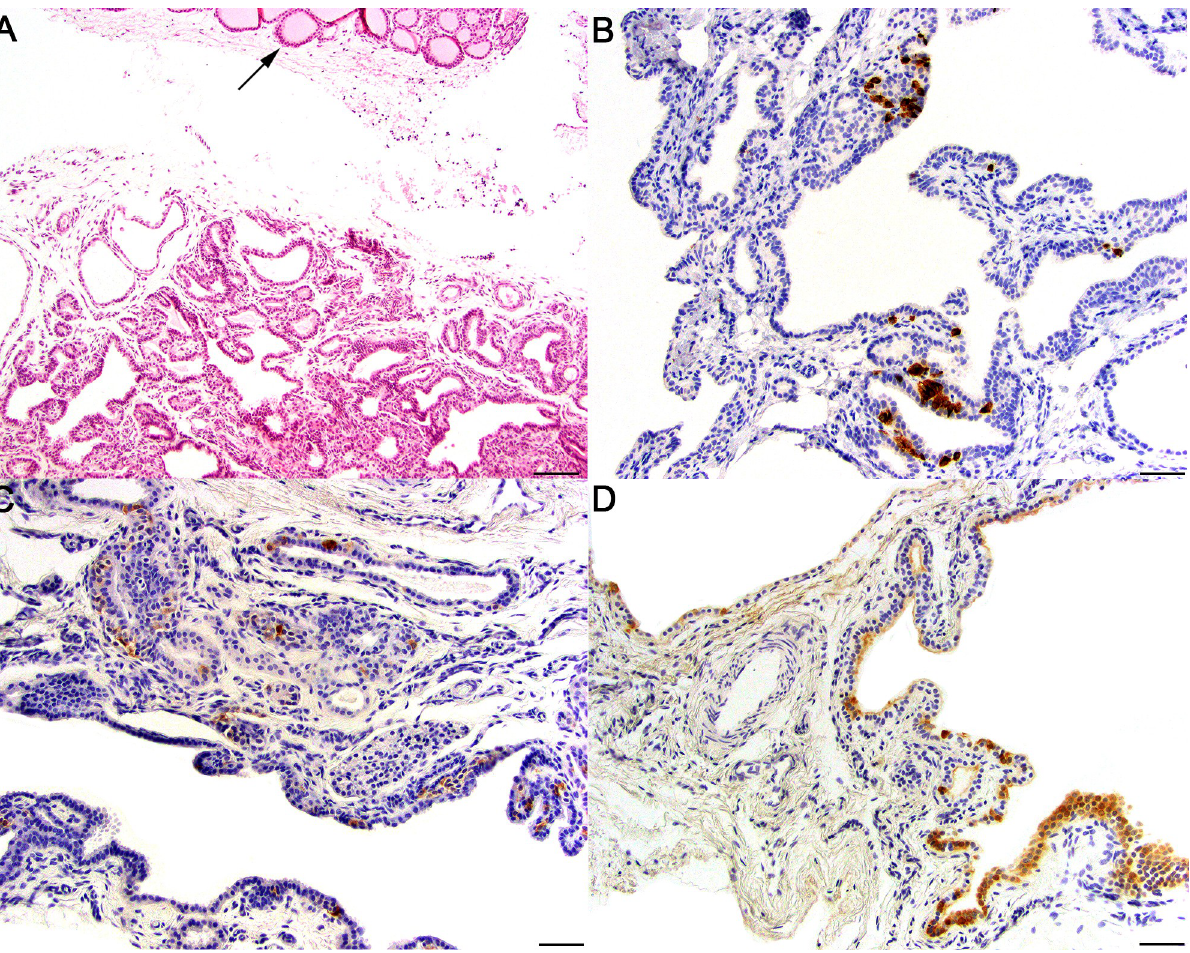
Fig 2. Necropsy of Case #3 . Normal parathyroid was not observed histologically. However, a cystic structure was identified adjacent to the thyroid gland (A; arrow = thyroid gland, scale bar = 100 μ m;), B-D This cystic structure had scattered immunoreactivity for (B) PTH, (C) calcitonin and (D) thyroglobulin (scale bar = 50 μ